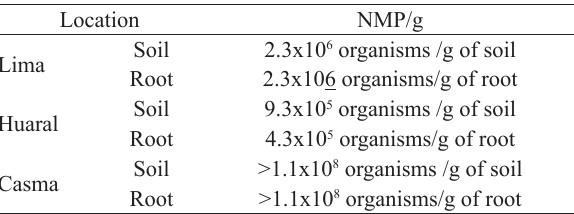
Table 2. Count of Pseudomonas spp. (NMP/g) isolated from the central coast of Peru.